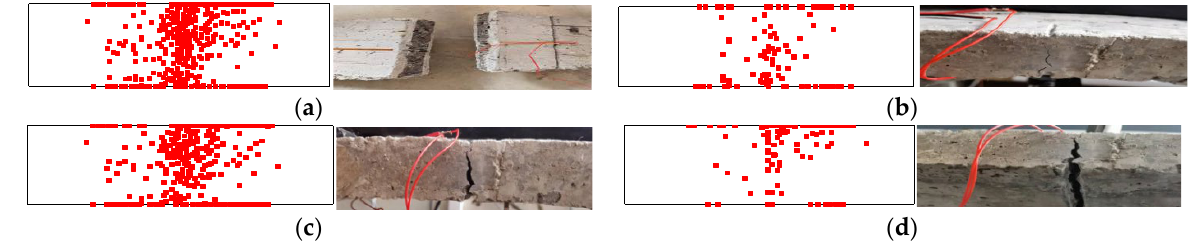
Figure 8. Acoustic emission identification results: ( a ) the final result of damage location; ( b ) concrete fracture stage in tension zone; ( c ) reinforcement yield strengthening stage; and ( d ) reinforcement fracture structure failure stage.